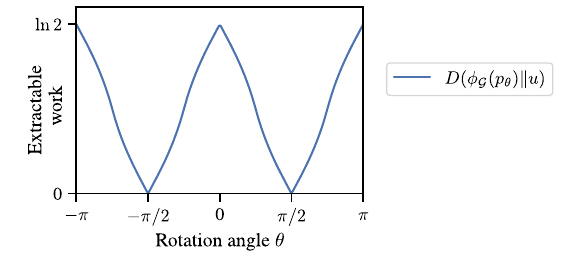
FIG. 6. Szilard box with symmetry constraints: the bound on extractable work as a function of θ [Eq.